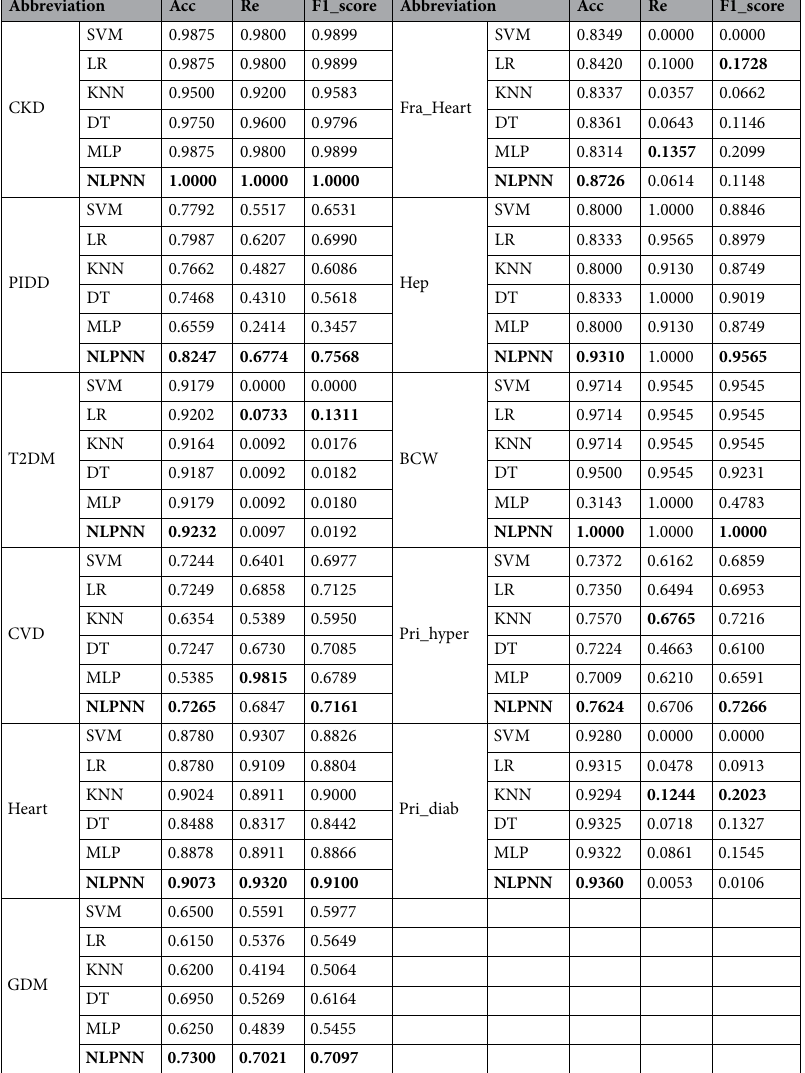
Table 4. Performance of different algorithms. The best results for each dataset are marked in